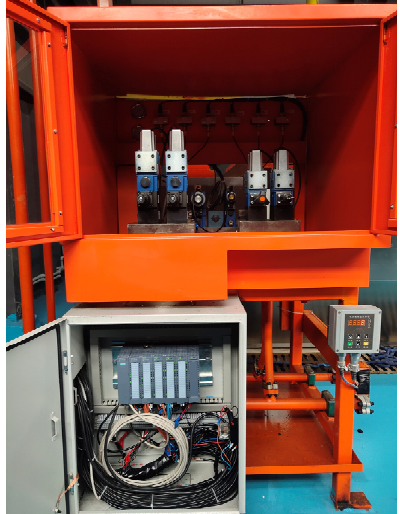
Figure 11. Assembly of the electrohydraulic servo valves and electrical control cabinet.